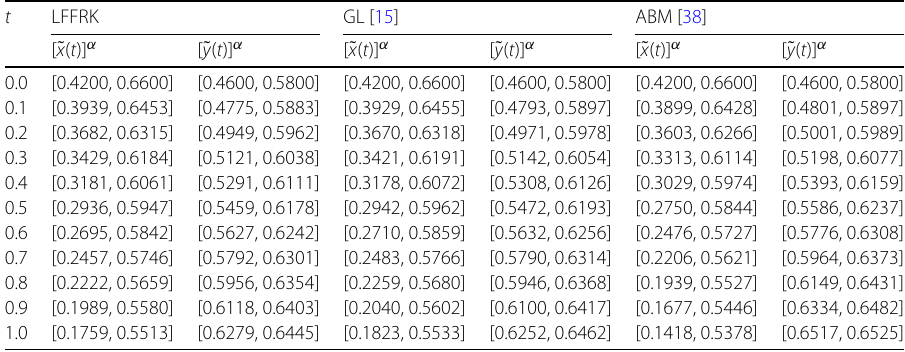
Table 5 Solutions of system (15) with the comparison to GL and ABM for σ = 0.95, α = 0.6 LFFRK GL